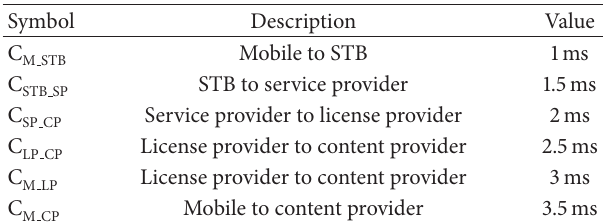
Table 2: Authentication cost